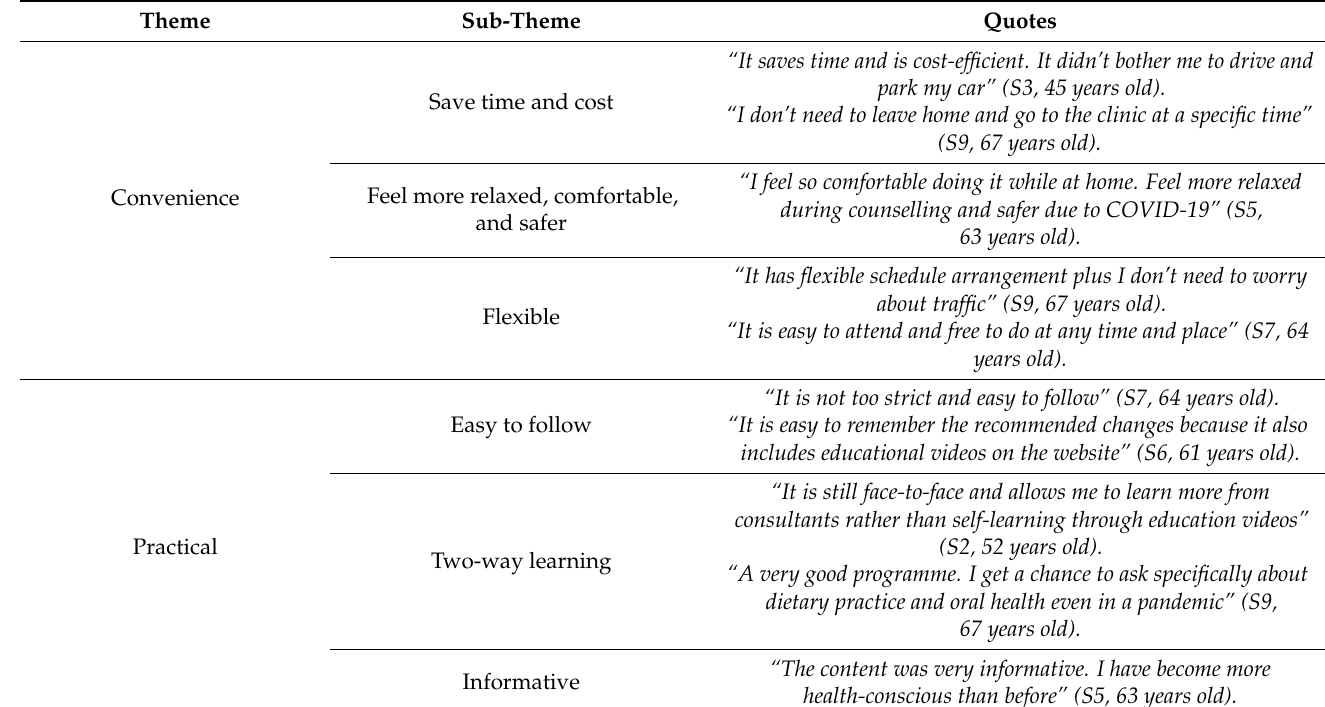
Table 3. Overall feedback on the online diabetes wellness